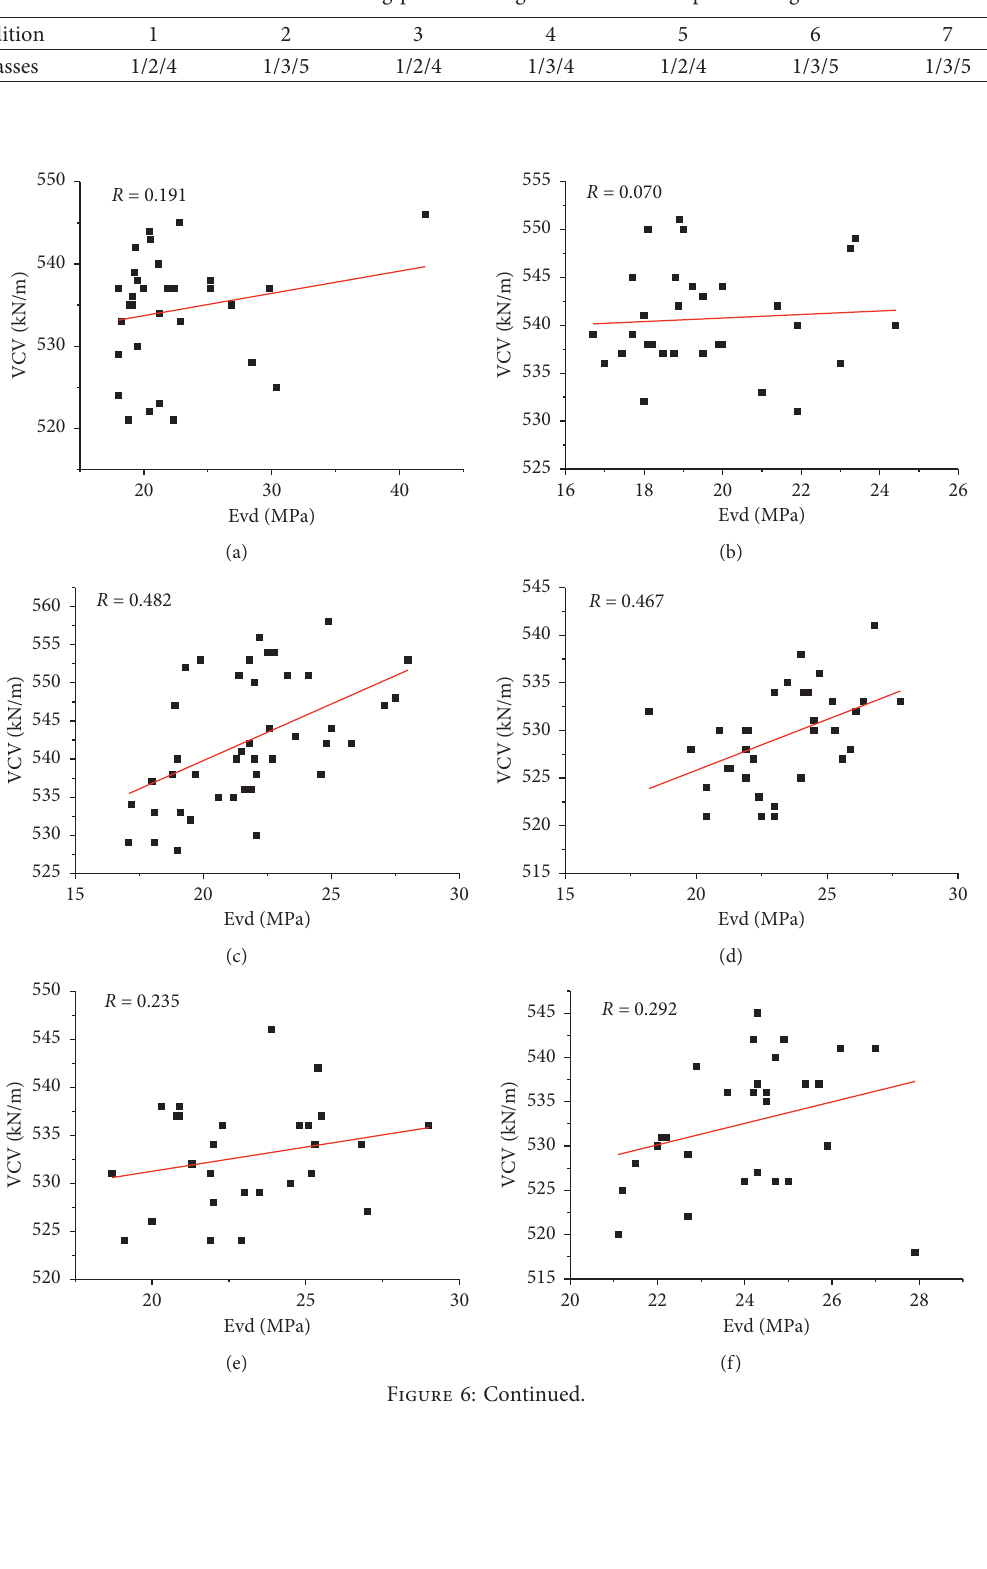
Table 3: Selection of rolling passes among the different compaction